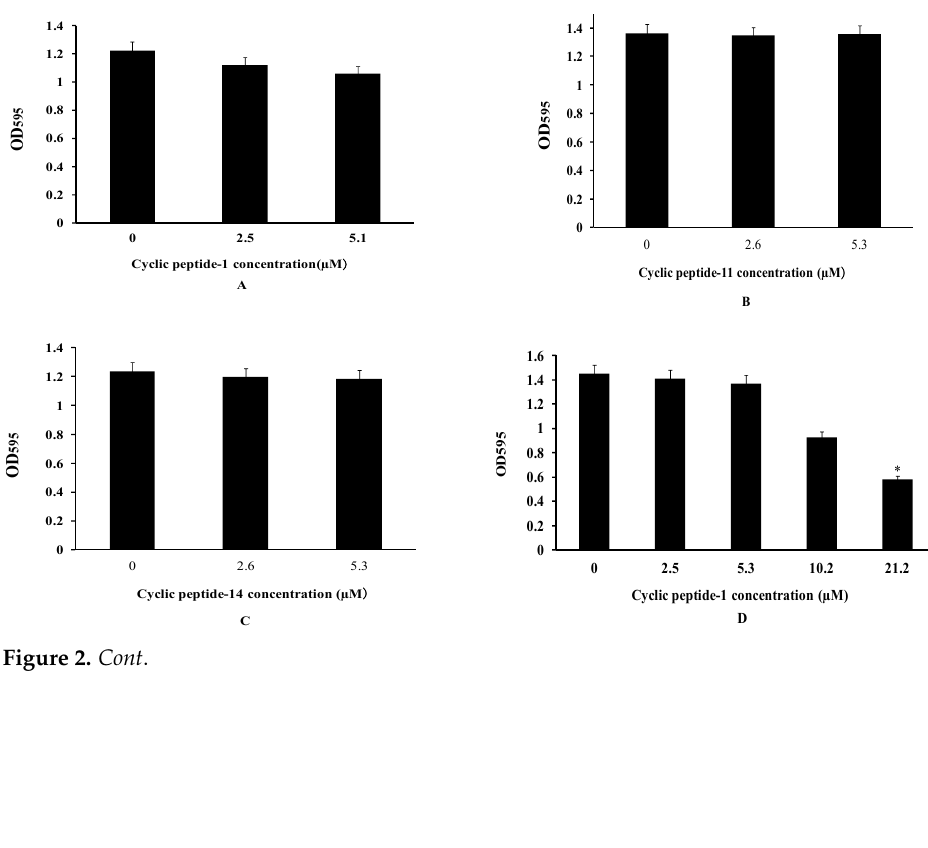
Figure 1. Time-kill curves of cyclic peptide-1, cyclic peptide-11, and cyclic peptide-14.